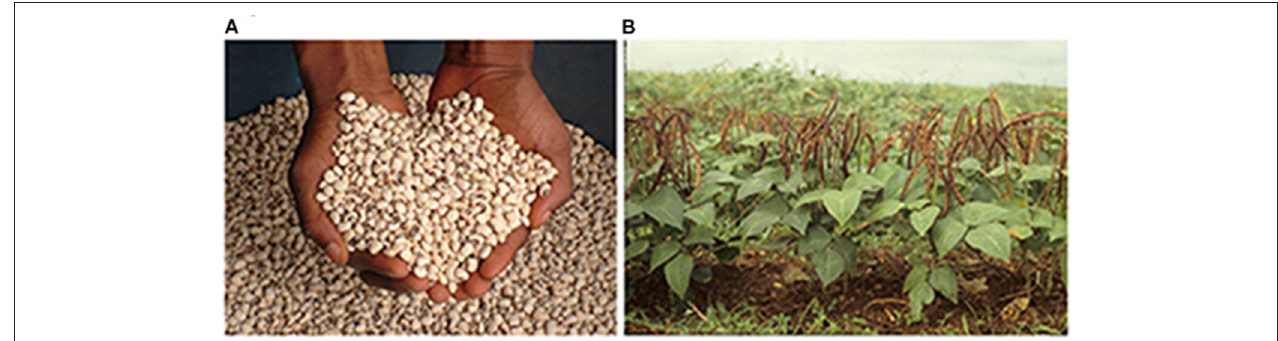
FIGURE 8 | Cowpea (Vigna unguiculata). (A) Cowpea dry grain. Source: Global Crop Diversity Trust. CC BY-NC-SA 2.0. (B) Cowpea plants at the podding stage. Source: IITA. CC BY-NC